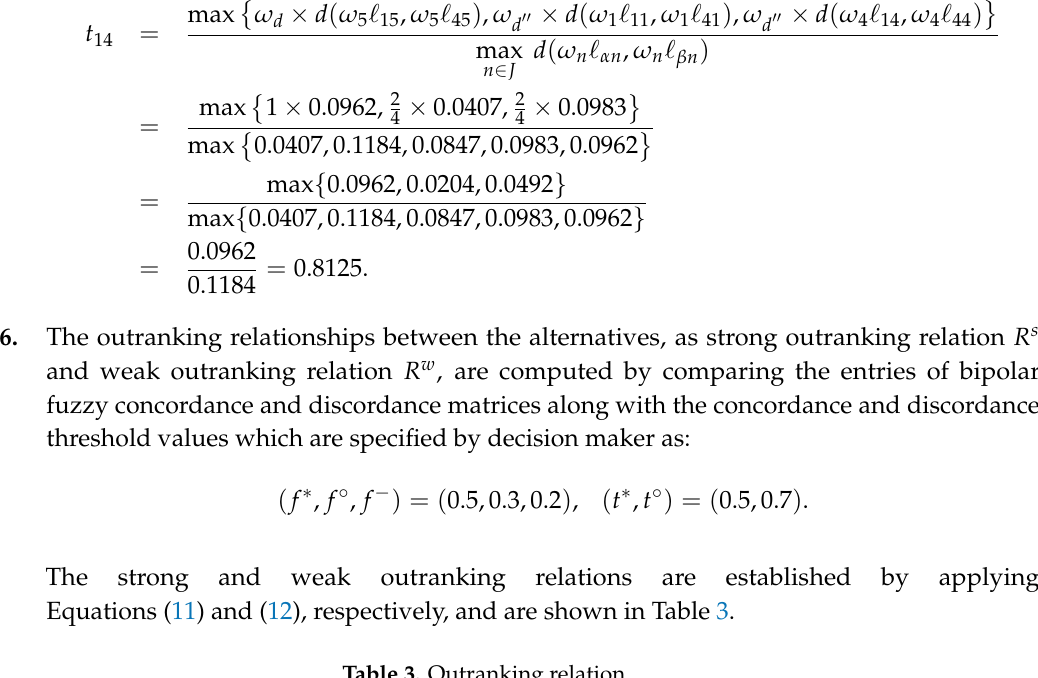
Table 3. Outranking relation.